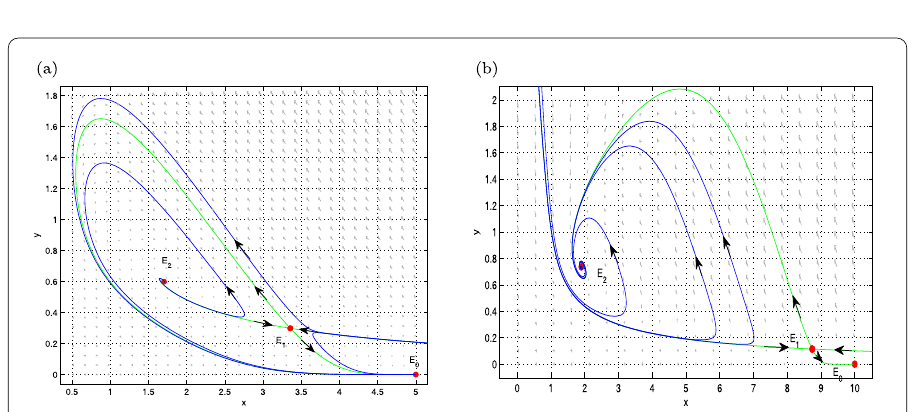
Figure 5 p = 2, q = 3, A = 1, γ = 0.1, equilibrium E 0 is locally stable, E 1 is a saddle and ( a ) d = 0.2, α = 0.1, E 2 is an attracting node; ( b ) d = 0.1, α = 1, E 2 is a repelling node